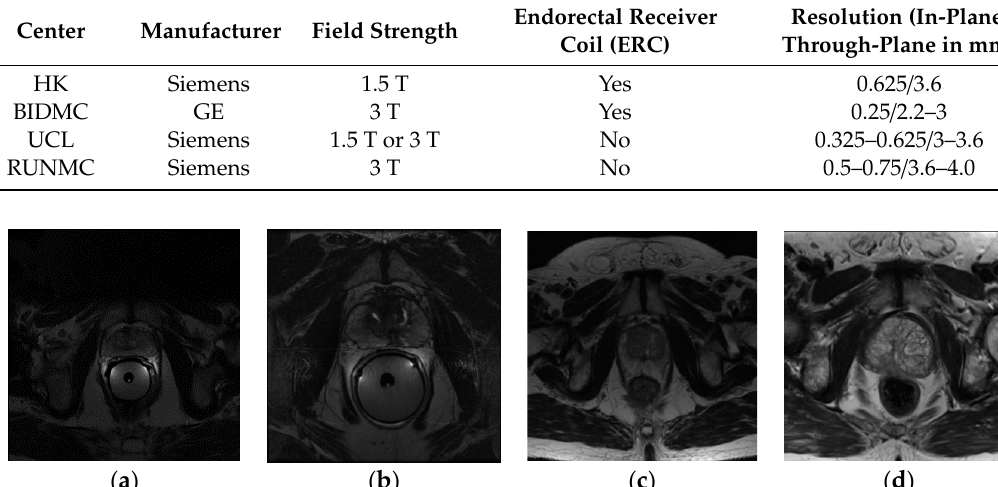
Table 1. Details of the acquisition protocols of PROMISE12 dataset.